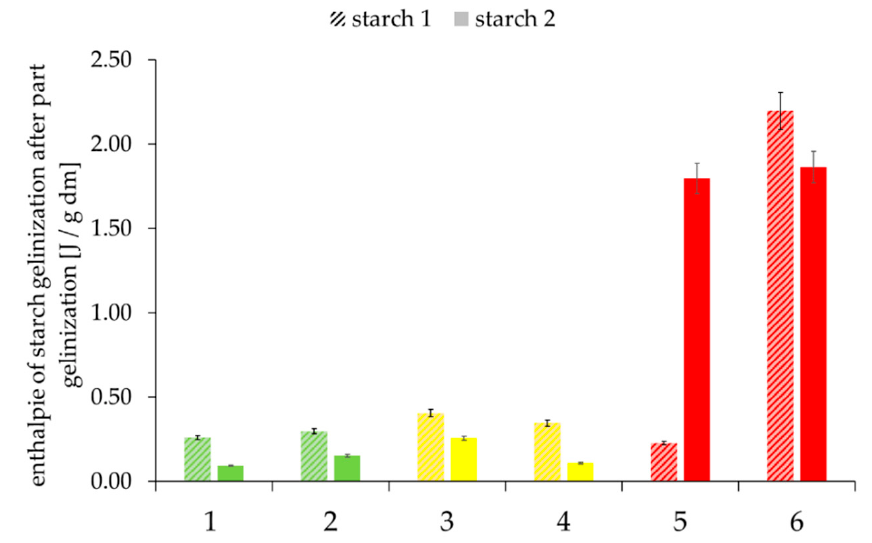
Figure 9. Residual enthalpy of partially gelatinized starch with excess water of the selected samples, depending on “good” to “medium” to “poor” baking quality and the corresponding falling number (FN) within the individual baking quality classes (here: first samples were always assigned the lower FN and second samples the higher FN). Sample description: see Table 1. Bars represent the mean value of two replicates; error bars represent the confidence interval.